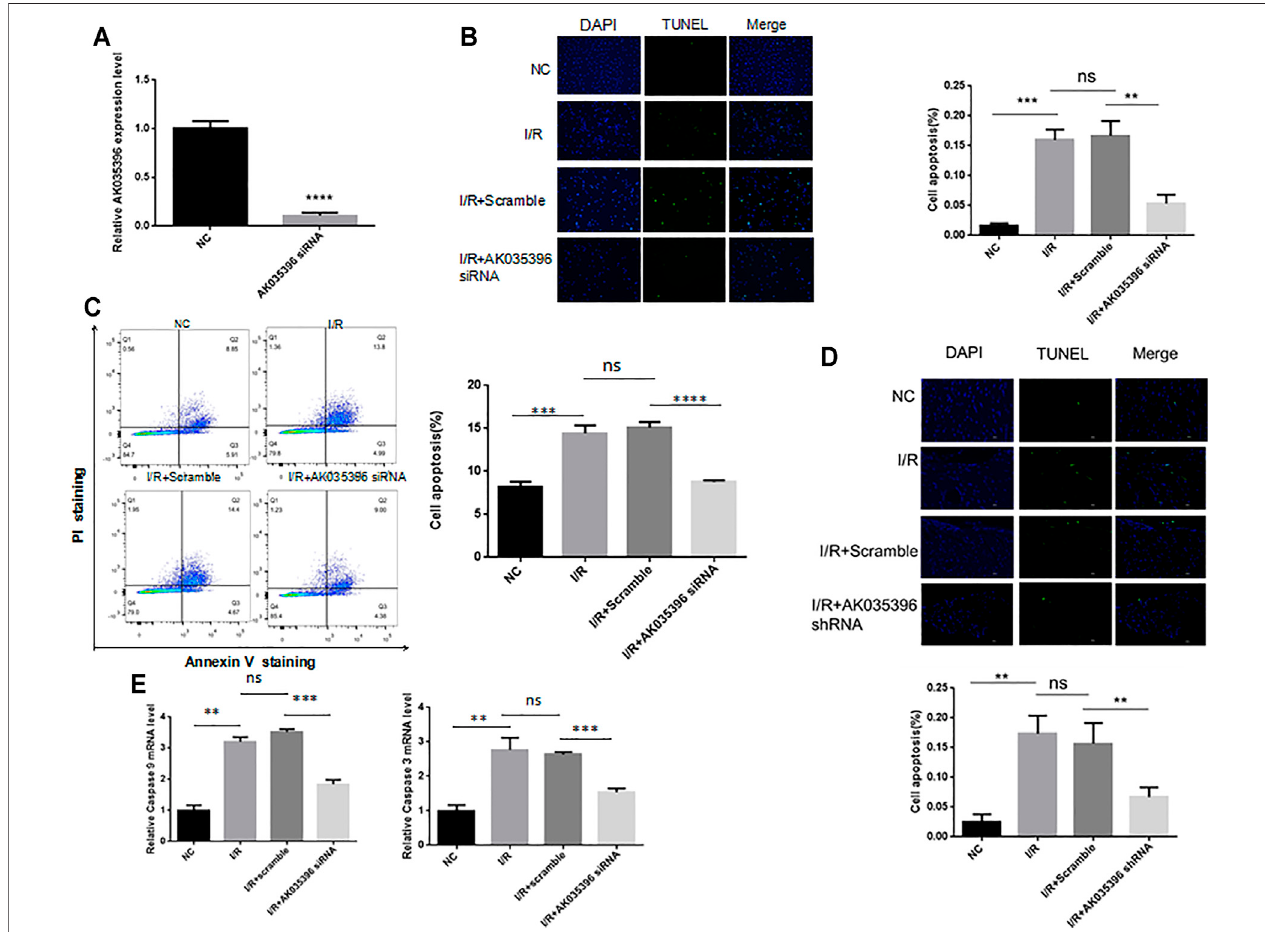
FIGURE 3 | Effect of AK035396 on apoptosis after myocardial ischaemia reperfusion. Primary cardiomyocytes were divided into four groups: NC, I/R, I/R + ScrambleandI/R+AK035396siRNA.C57BL/6miceweredividedintofourgroups:NC,I/R,I/R+ScrambleandI/R+AK035396shRNA.ATUNELapoptosisdetection kit was used to measure apoptosis in each group. (A) The knockdown ef fi ciency of AK035396 siRNA was determined by qRT – PCR. (B) Primary cardiomyocyte apoptosis was measured by TUNEL staining (green). The nucleus was counterstained with 4 ′ ,6-diamidino-2-phenylindole (DAPI, blue). (C) Flow cytometry was usedtomeasureapoptosisinprimarycardiomyocytes. (D) ApoptosisinmousemyocardialwasdeterminedbyTUNELstaining(green).Thenucleuswascounterstained with 4 ′ ,6-diamidino-2-phenylindole (DAPI, blue). NC: Normal control; I/R: Ischaemia reperfusion. (E) The expression of caspase3 and caspase9 was measured by qRT –